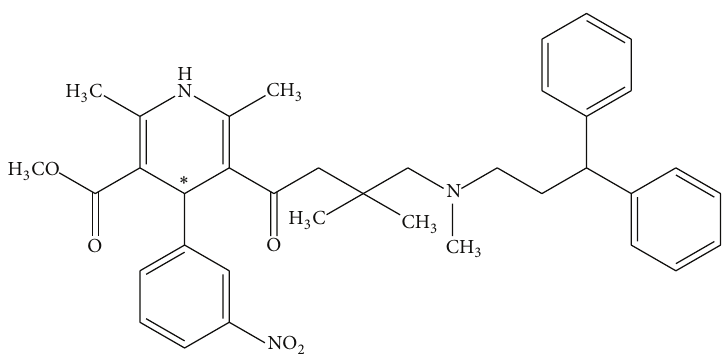
Figure 1: Chemical structure of LER ( ∗ : chiral